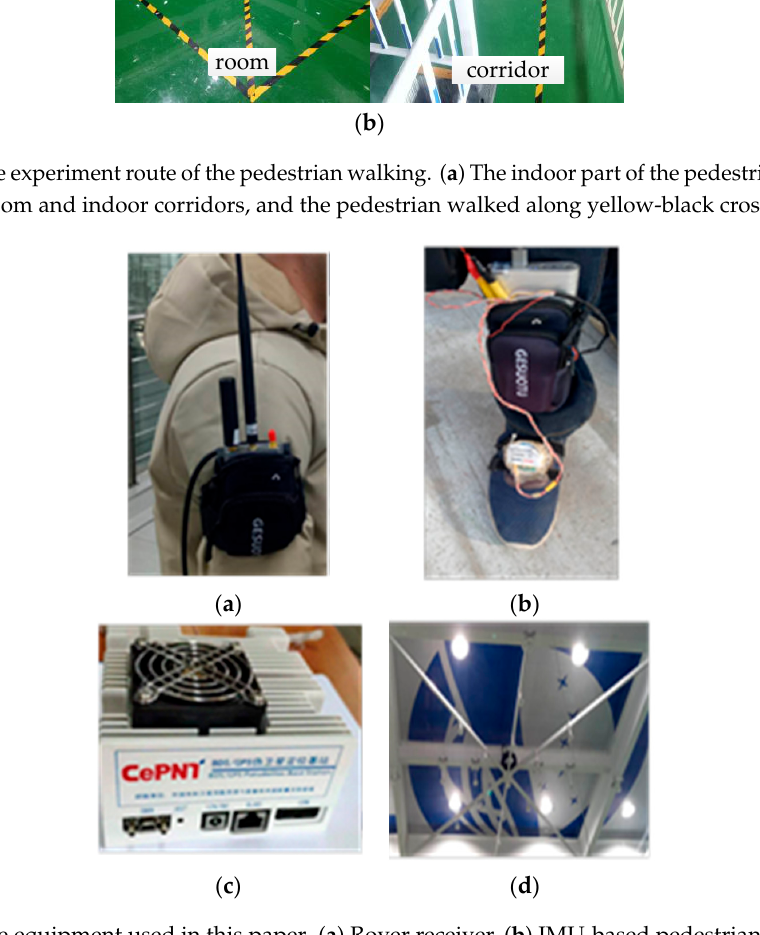
Figure 9. The equipment used in this paper. ( a ) Rover receiver, ( b ) IMU-based pedestrian navigation system, ( c ) pseudolite base station, ( d ) pseudolite antennas. system, ( c ) pseudolite base station, ( d ) pseudolite Table 1. Quality indicators.